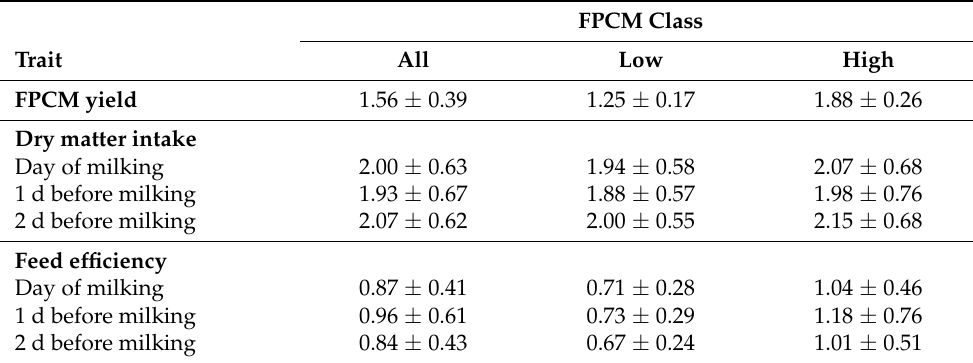
Table 1. Individual fat – protein-corrected milk (FPCM), dry matter intake, and feed efficiency during the experimental trial.